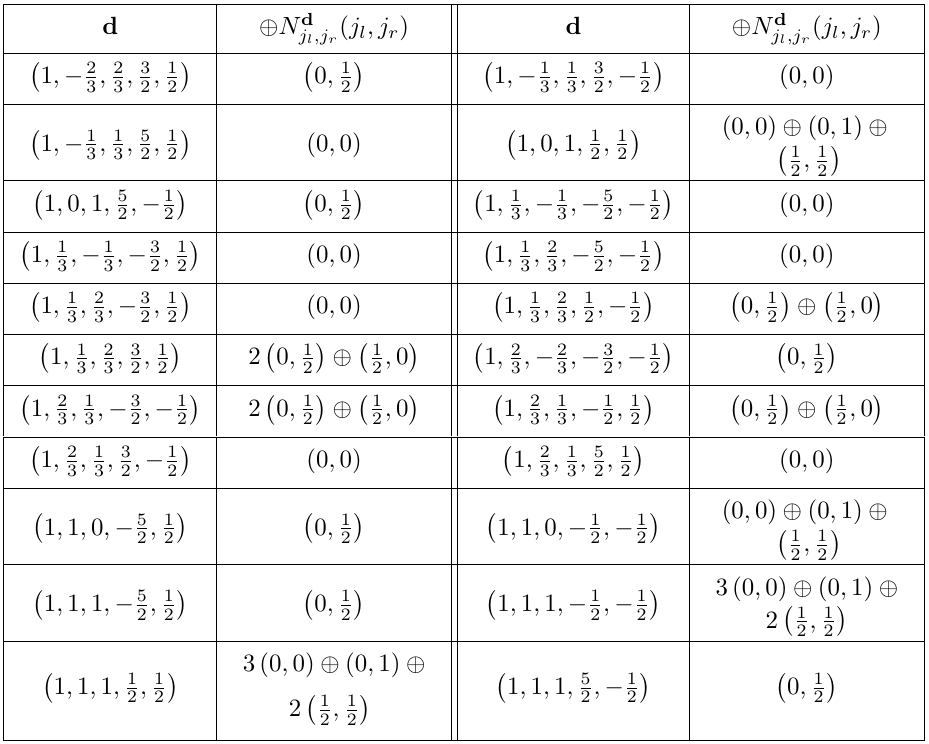
Table 23. BPS spectrum of the SU(3) 0 + 1 Sym + 1 F theory. Here, d = ( d 1 , d 2 , d 3 , d 4 , d 5 ) labels the BPS states with charge d 1 m 0 + d 2 α 1 + d 3 α 2 + d 4 m 1 + d 5 m 2 where α 1 and α 2 are simple roots of su (3)